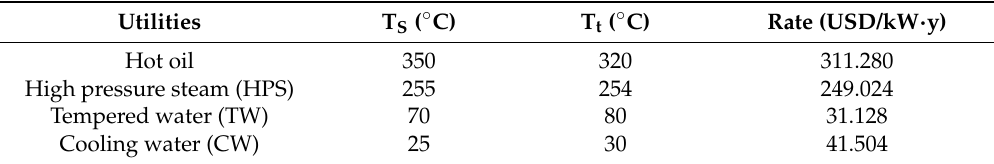
Table 8. Multiple utilities data